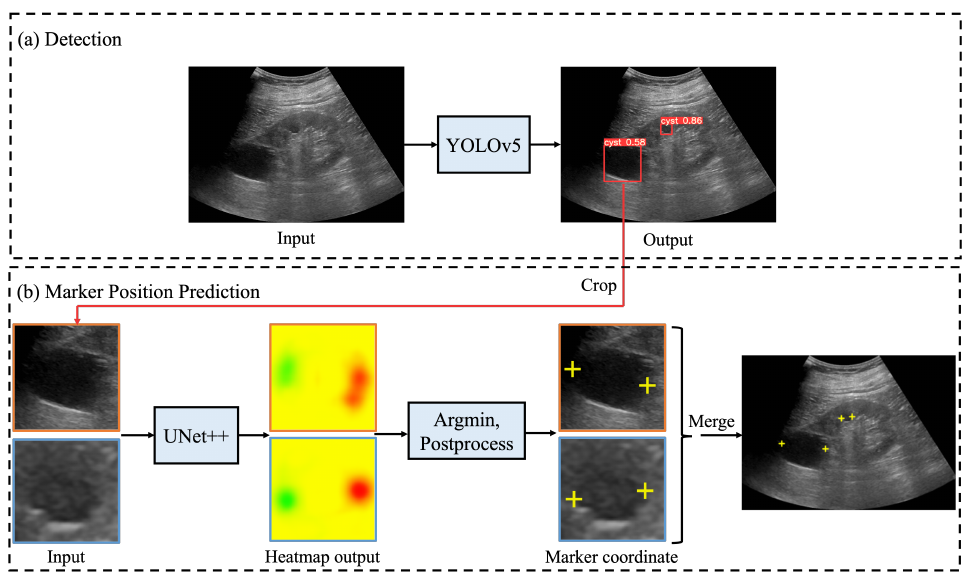
Figure 2. Processing flow of automated system for assigning salient landmarks to renal cysts: ( a ) ultrasound images are input into YOLOv5 [20] to detect renal cysts; ( b ) the area around the detected renal cyst is extracted and input to UNet++ [21] to predict the saliency map (represented by a heatmap) of the salient landmark position; in post-processing, the point with the smallest saliency map value from the output saliency map is selected and used as the appropriate coordinate. If necessary, the coordinates are corrected and the appropriate coordinates determined. Finally, all predicted salient landmarks are plotted on the original